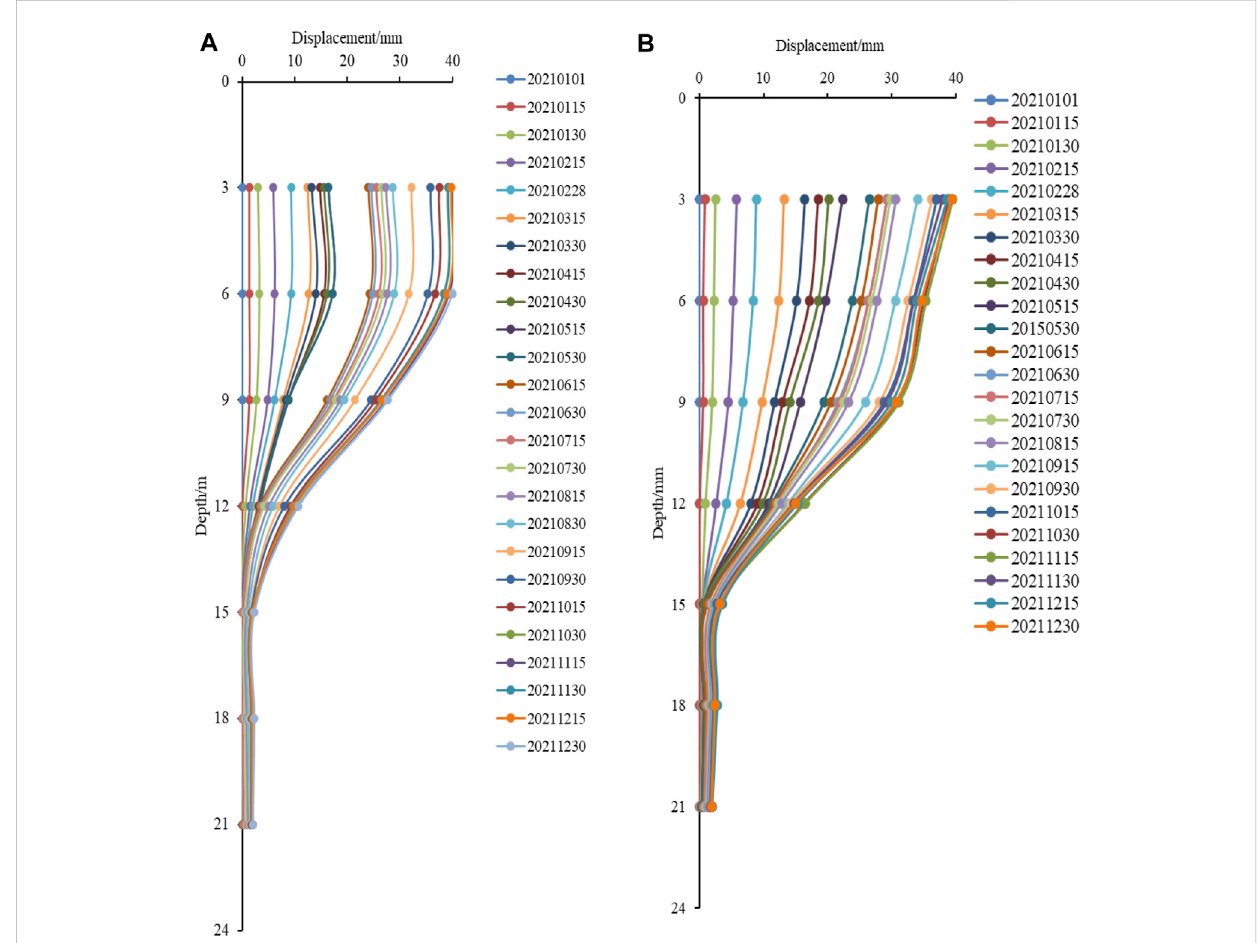
FIGURE 16 (A) X-directional; (B) Y-directional displacement variation curve of F4 fi xed inclination